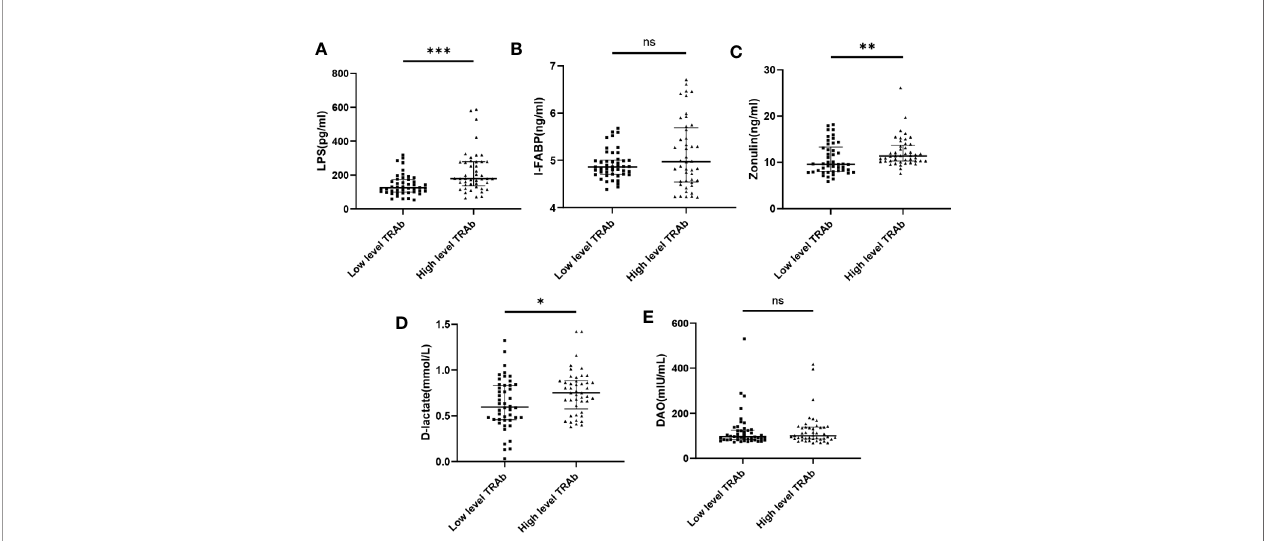
FIGURE 3 | Leaky gut biomarkers associated with TRAb levels in GD. Comparison of serum levels of LPS (A) , I-FABP (B), zonulin (C) , D-lactate (D) and DAO (E) in patients with GD between low and high TRAb subgroup. Bars represent the mean ± SD. * p < 0.05; ** p < 0.01; *** p < 0.001. "ns" indicates not signi fi cant.